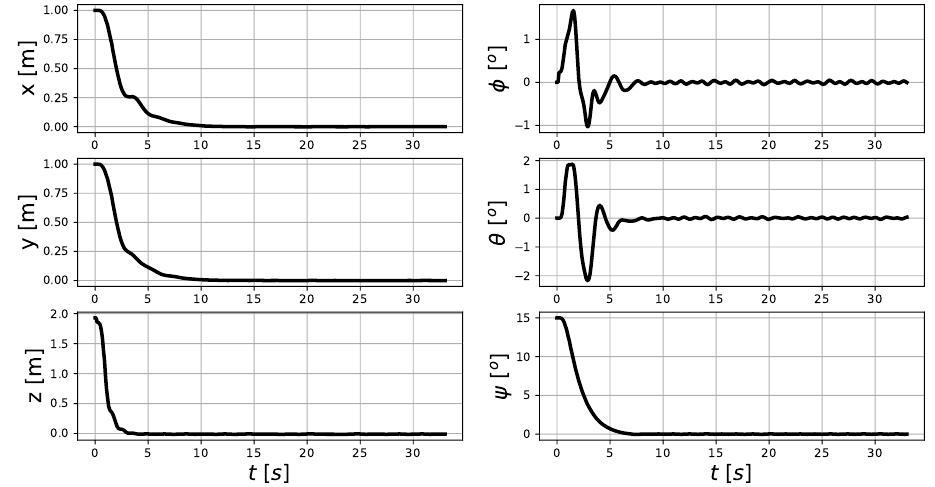
Figure 9. Error signals for the controlled states of the passively tilted